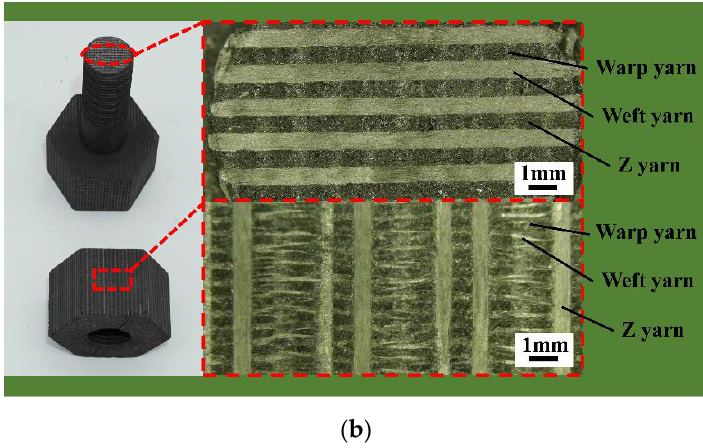
Figure 1. ( a ) The preform weaving mode and fiber direction; ( b ) microstructure of C/C fasteners. Table 1. Material performance of the adherend and fastener at 800 °C. Variable Adherend Fastener